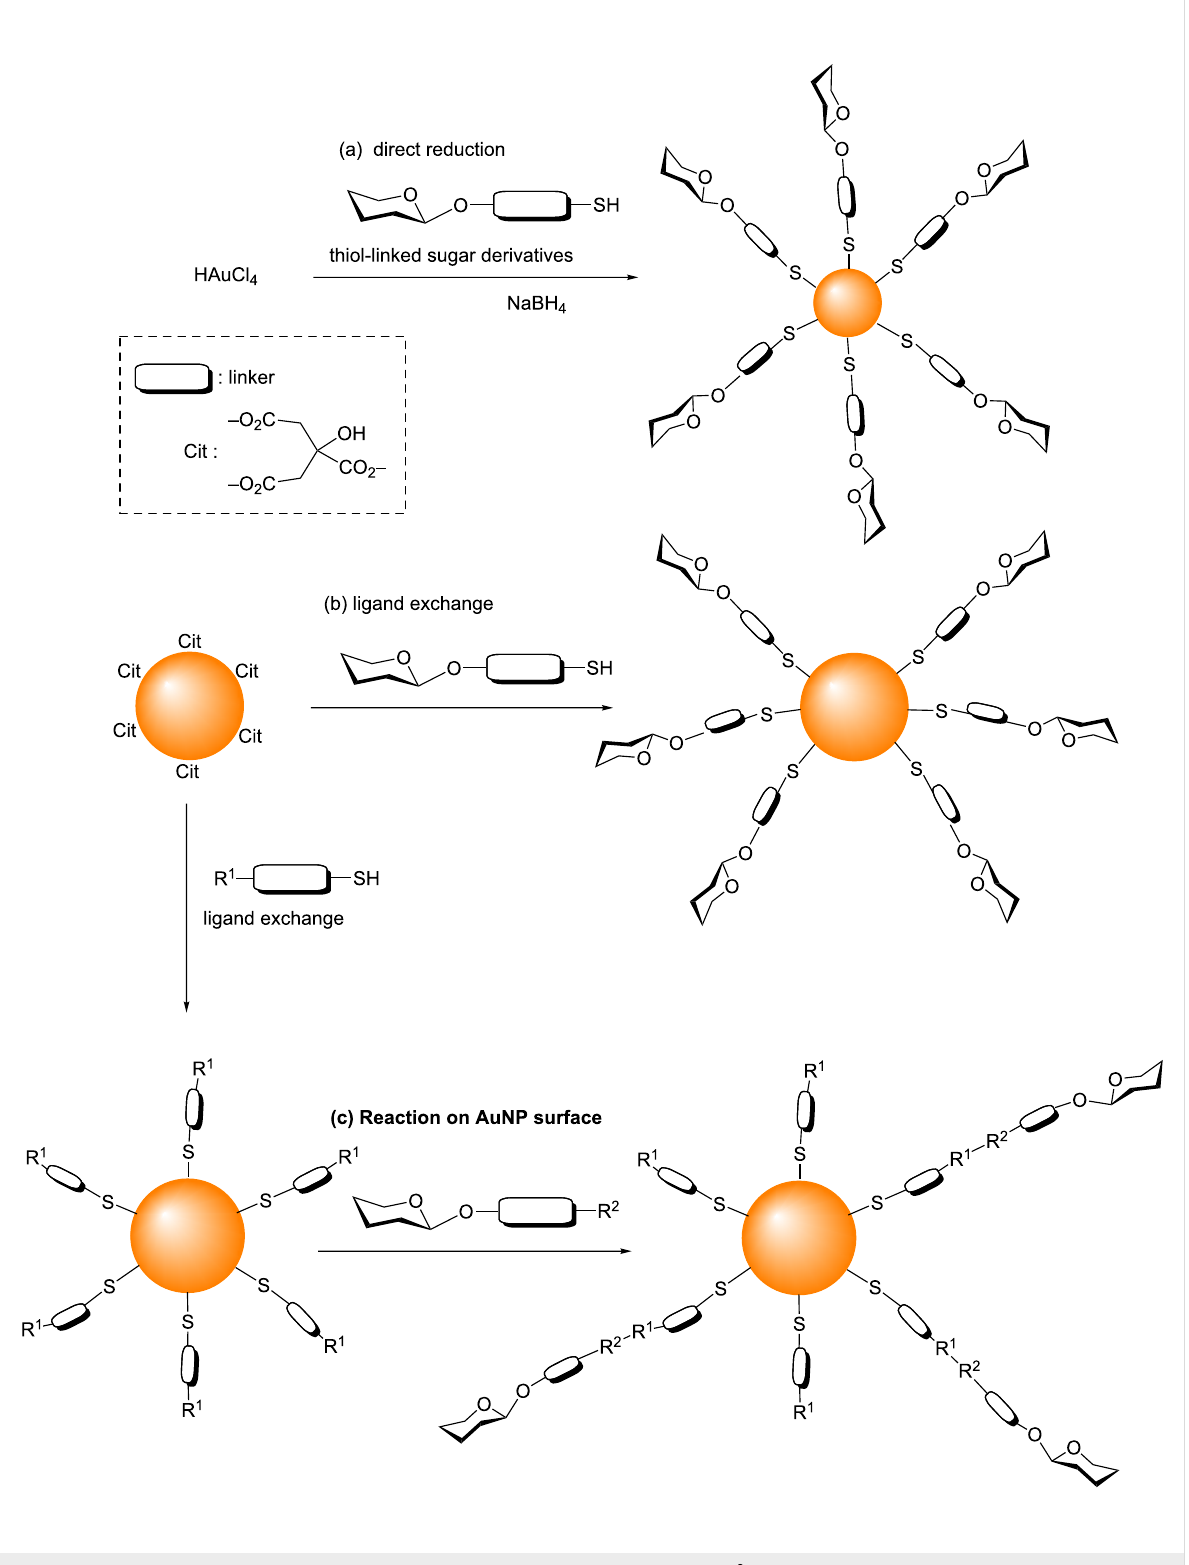
Figure 1: The three major methods for the synthesis of GAuNPs. (a) Direct reduction of an Au 3+ salt in the presence of thiol-linked sugar derivatives to obtain GAuNPs of sizes smaller than 10 nm. (b) Exchange of citrate molecules (cit) on citrate-stabilized AuNPs with thiol-linked sugar derivatives to obtain GAuNPs of various sizes. (c) Reactions of AuNPs (obtained after ligand exchange) with suitably functionalized sugar